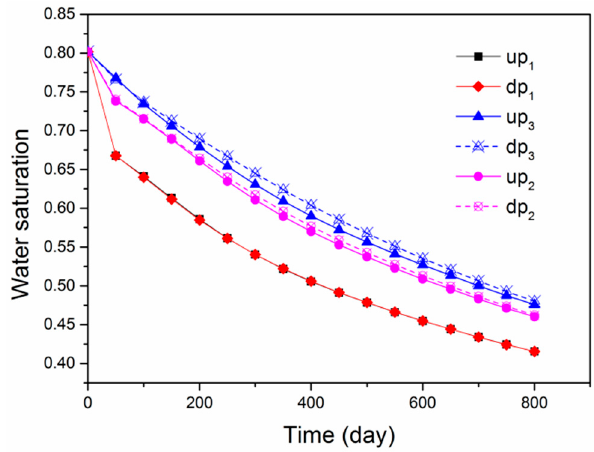
Figure 15. Evolution of water saturation at the three couples of points along the